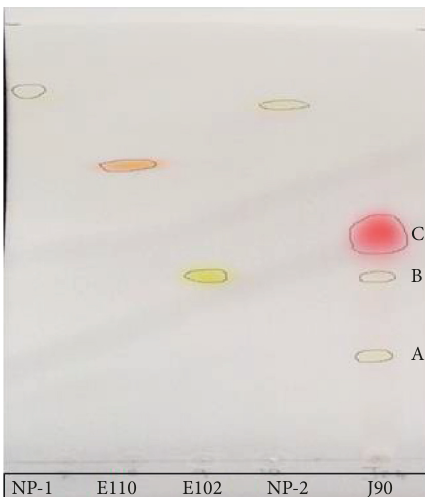
Figure 4: TLC analysis of J90 red instant jelly sample in the solvent system (butanol: water:glacial acetic acid � 10:6 :5) which is used to identify yellow and orange synthetic colours. NP-1: nonpermitted Bromocresol purple; NP-2: nonpermitted Metanil yellow; E110: per- mitted standard Sunset yellow FCF; E102: permitted standard Tartrazine; A identified nonpermitted yellow colour spot; B identified Tartrazine colour spot; C identified red colour spot in jelly sample (Ponceau 4R-E